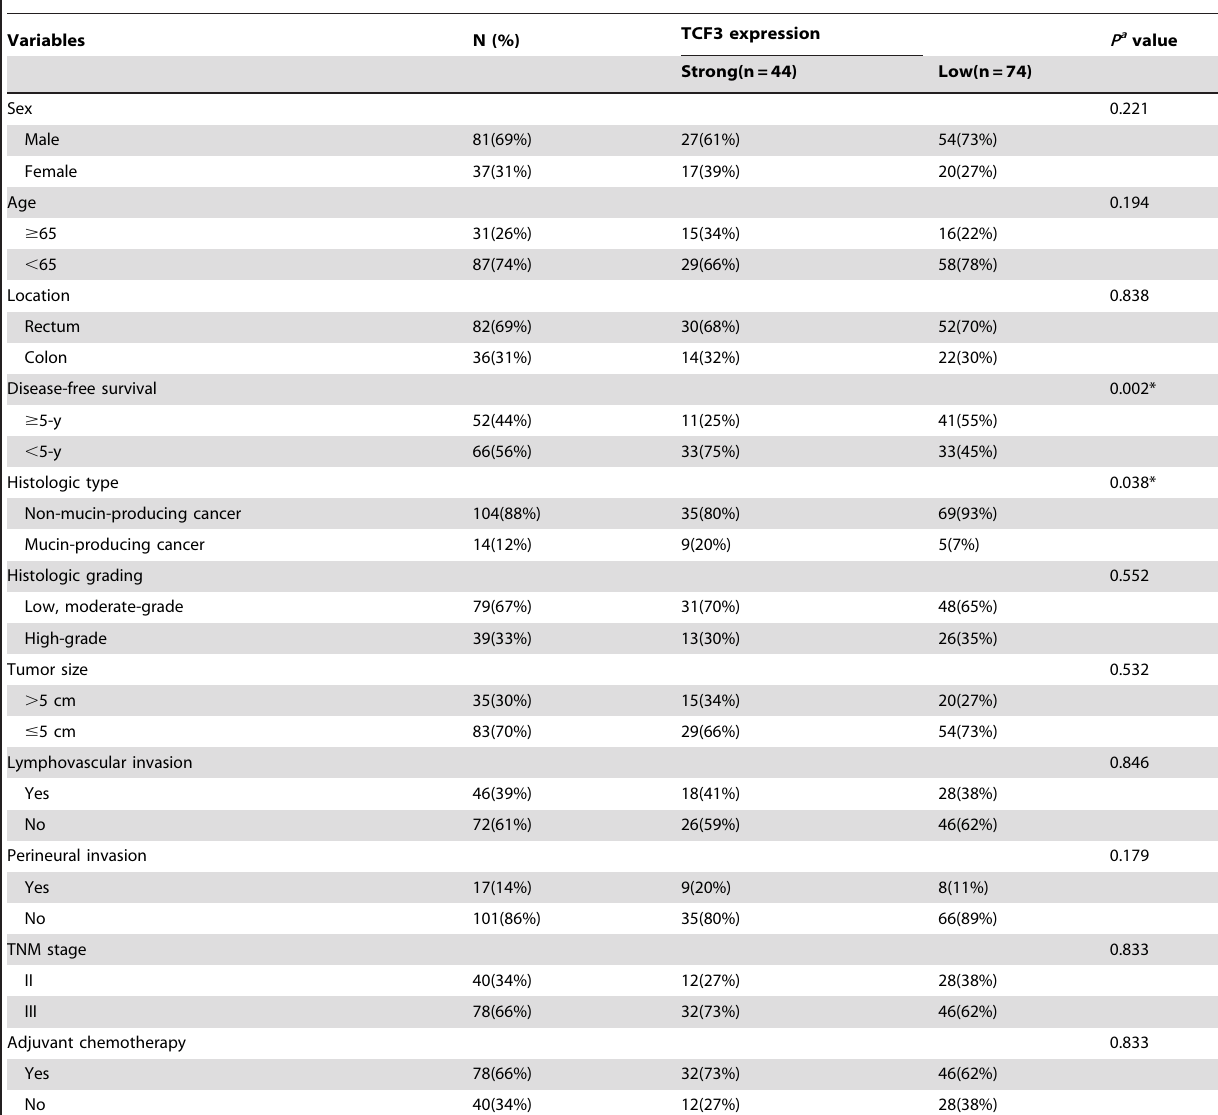
Table 2. Relationships between clinicopathologic features and TCF3 expression in colorectal